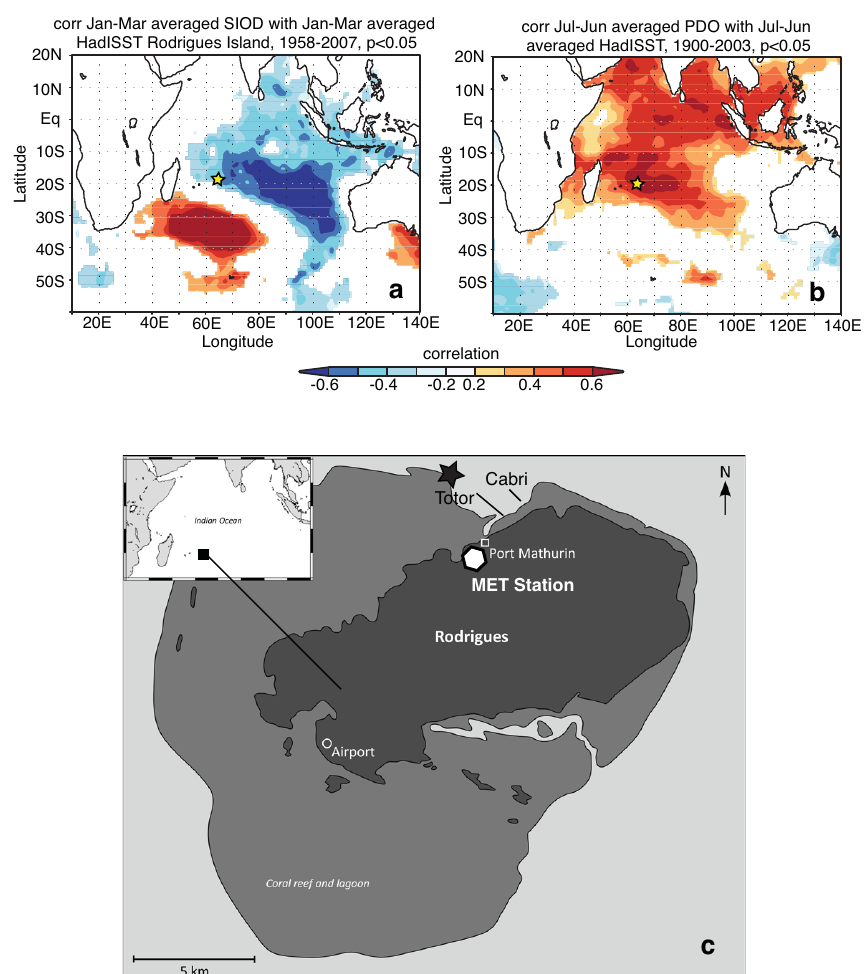
Figure 1. (a) Spatial correlation between January and March averaged SIOD index (Behera and Yamagata, 2001) with HadISST (Rayner et al., 2003) for Rodrigues Island. (b) Spatial correlation between July and June mean annual averaged PDO index (Mantua et al., 1997) with HadISST (Rayner et al., 2003). All correlations with detrended data. Only correlations with p < 0.05 are coloured. Computed at KNMI Climate Explorer (van Oldenborgh and Burgers, 2005). The yellow star in (a) and (b) marks the location of Rodrigues Island. (c) Map of Rodrigues Island with the position of the two coral cores at Totor and Cabri indicated. The star shows the position of the CTD that collects SST and salinity data. The polygon indicates the location of the meteorological station, which records air temperature, sunshine hours, wind speed and